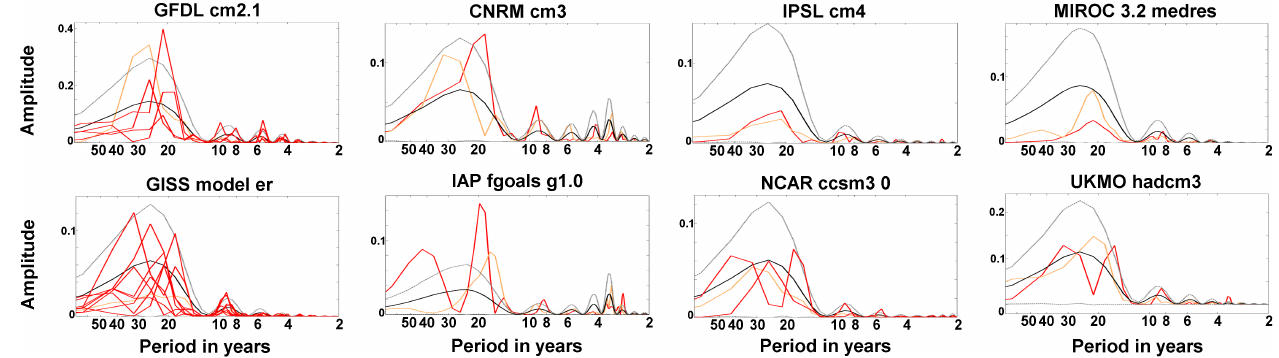
Fig. 10. Power spectra of the box B sea level trend computed over successive 17-yr windows and NINO3 index from the coupled climate models. The red curves indicate the power spectra from the 20c3m runs. The orange curves indicate the power spectra from their respective control runs and the black curves their respective best fit AR2 process. The grey dashed lines indicate the 95% confidence level computed from the control runs best fit AR2